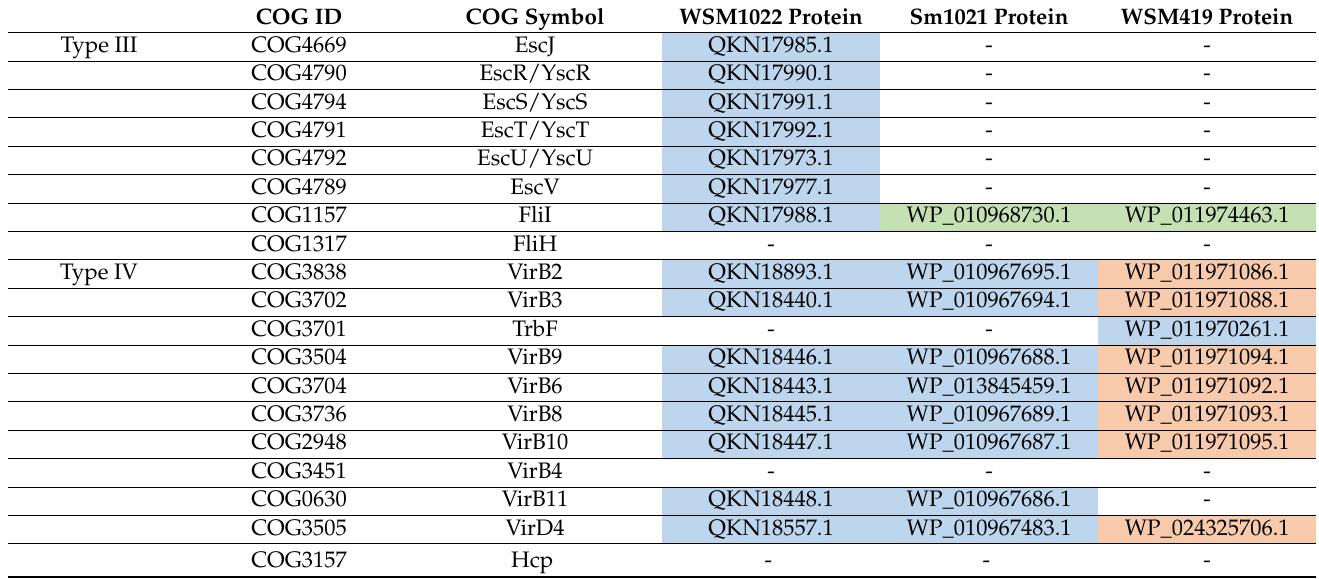
Table 2. Type III and IV secretion system proteins present in each genome. EffectiveS346 predictions of presence/absence of Type III and Type IV secretion system components in the three genomes. Missing components are indicated by “-“. Chromosome/plasmid locations of the corresponding genes are indicated with background colours for plasmid pA/pSymA/pSMED02 (blue), chromosome (green) and pSMED03